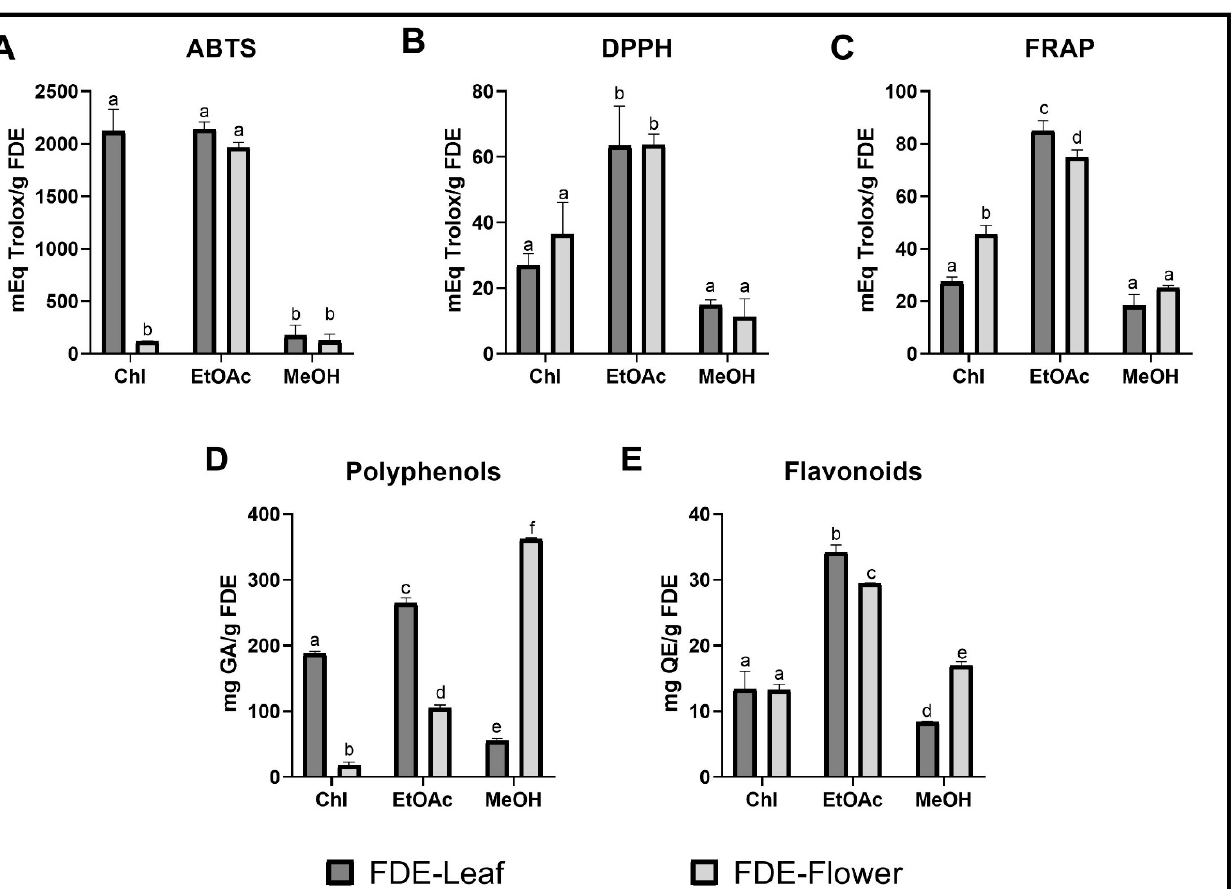
Figure 3. Antioxidant activity and quantification of secondary metabolites in the different fractions of P. peltatum . The antioxidant activity was determined by ( A ) ABTS, ( B ) DPPH, and ( C ) FRAP. The quantified secondary metabolites were ( D ) polyphenols and ( E ) flavonoids. Chl: Chloroform fraction, EtOAc: ethyl acetate fraction, MeOH: methanol fraction. The histogram shows the values of the means ± S.D. of three independent experiments and the Tukey L.S.D. test showing homogeneous groups with a p < 0.005. Different lowercase letters (a, b, c, d and e) on the top of columns represent significant difference (p < 0.05).